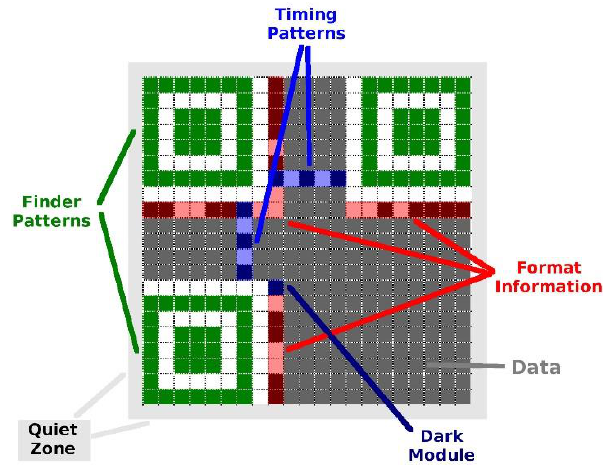
Figure 1. Version 1: 21 × 21 QR Code.